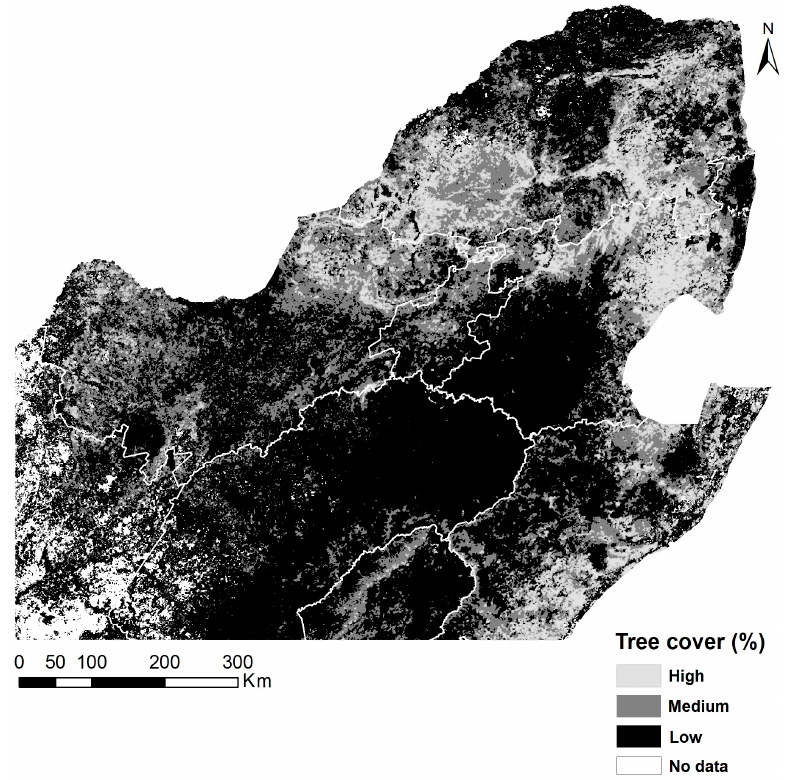
Figure 10. Tree cover (%) derived from the day of the austral year at maximum senescing rate (a land surface phenological metric).